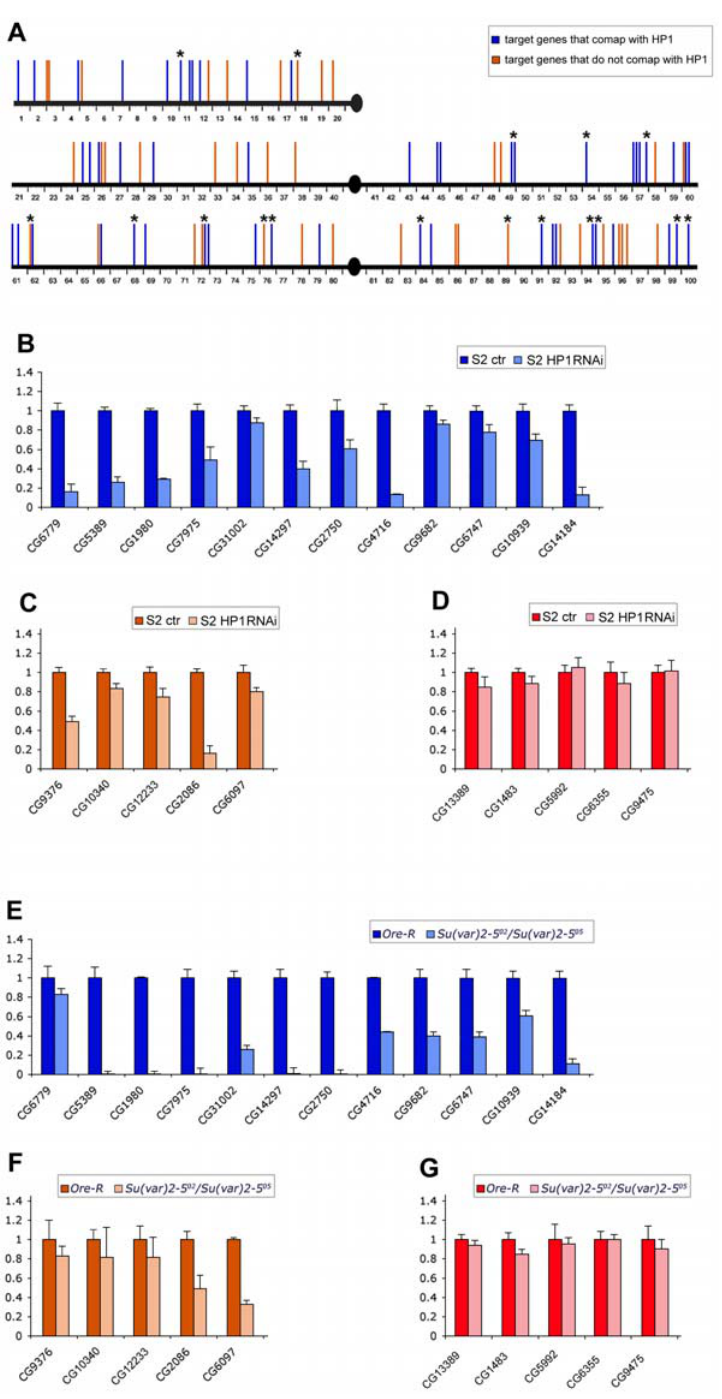
Figure 2. The genes corresponding to transcript targets of HP1a in S2 cells show a good overlap with HP1a binding sites on polytene chromosomes and appear down-regulated in both S2 cells lacking HP1a and HP1a mutant larvae. (A) Localization of HP1a binding sites and the genes corresponding to the HP1a target transcripts along polytene chromosomes of Drosophila wild type larvae. Blue bars represent sites where the HP1a target genes overlap with HP1a immunosignals; orange bars indicate the localization of HP1a target genes that do not overlap with HP1a immunosignals. (B) Quantitative RT–PCR analysis of the expression, in S2 cells treated with dsRNA of HP1a, of a sub-set of target genes that overlap with HP1a on polytene chromosomes whose position is indicated in (A) by blue bars marked with asterisks and (C) a sub-set of HP1a target genes that do not overlap with HP1a on polytene chromosomes whose position is indicated in (A) by orange bars marked with asterisks. (D) Quantitative RT-PCR analysis of the expression, in S2 cells treated with dsRNA of HP1a, of a sub-set of genes that were not found among the HP1a target genes in S2 cells and do not co-map with any of the HP1a immunosignals along the polytene chromosomes. (E) Quantitative RT-PCR analysis of the expression, in wild type and HP1a mutant larvae, of the same sub-set of target genes reported in Figure 2B. (F) Quantitative RT-PCR analysis of the expression, in wild type and HP1a mutant larvae, of the same sub-set of target genes reported in Figure 2C. (G) Quantitative RT-PCR analysis of the expression, in wild type and HP1a mutant larvae, of the same sub-set of non target genes reported in Figure 2D.